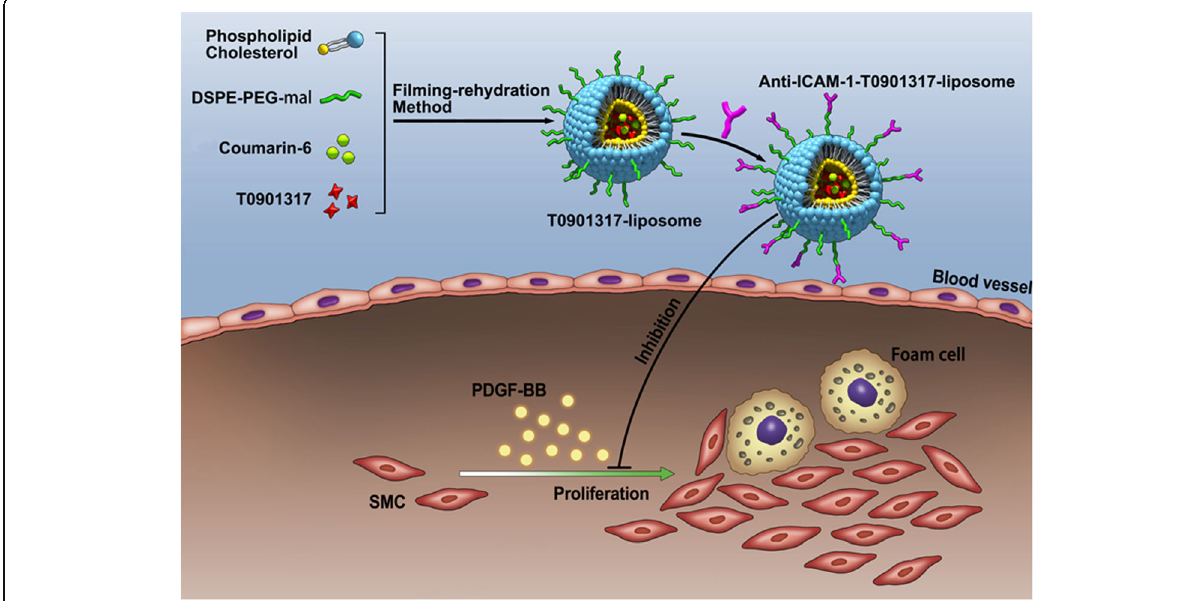
Fig. 1 The scheme representing the subject of the article shows that the anti-ICAM-1-T0901317 liposomes were prepared by filming-rehydration method. Some specific materials contain phospholipid, cholesterol, T0901317, DSPE-PEG-mal, coumarin-6, and anti-ICAM-1. And the anti-ICAM-1- T0901317 liposomes can inhibit PDGF-induced proliferation of vascular smooth muscle cells